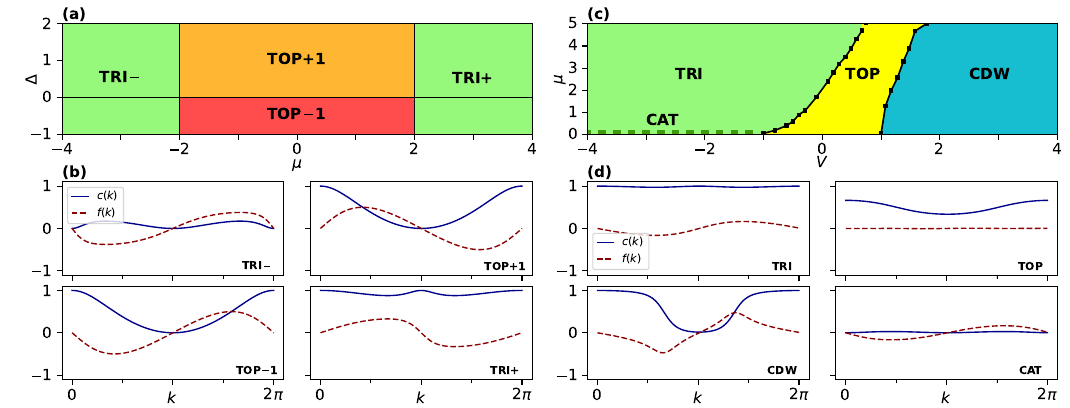
Figure 1: Phase diagrams and correlation functions. (a) Phase diagram of the non- interacting Kitaev model obtained from the winding number. The model presents three phases: A trivial phase with winding number ν = 0 (green), that we distin- guish for convenience in TRI- when µ < − 2 and TRI + when µ > + 2, two super- conducting topological phases with winding number ν = + 1 (TOP + 1, orange) and ν = − 1 (TOP − 1, red). The black lines represent phase transition lines. (b) Corre- lation functions of the non interacting model obtained from the analytical solution of the model. Each panel corresponds to a different region of the phase diagram. (c) Phase diagram of the interacting model. It presents four phases, of which three are trivial: Schrödinger-cat-like phase (CAT, dark green dashed line), charge-density wave (CDW, blue), trivial superconducting phase (TRI, green), and topological su- perconducting phase (TOP, yellow). The phase transition points (black squares) were obtained numerically by looking at the number of edge modes. (d) Correlation func- tions of the interacting Kitaev model obtained through the DMRG algorithm. The four graphs correspond to different regions of the phase